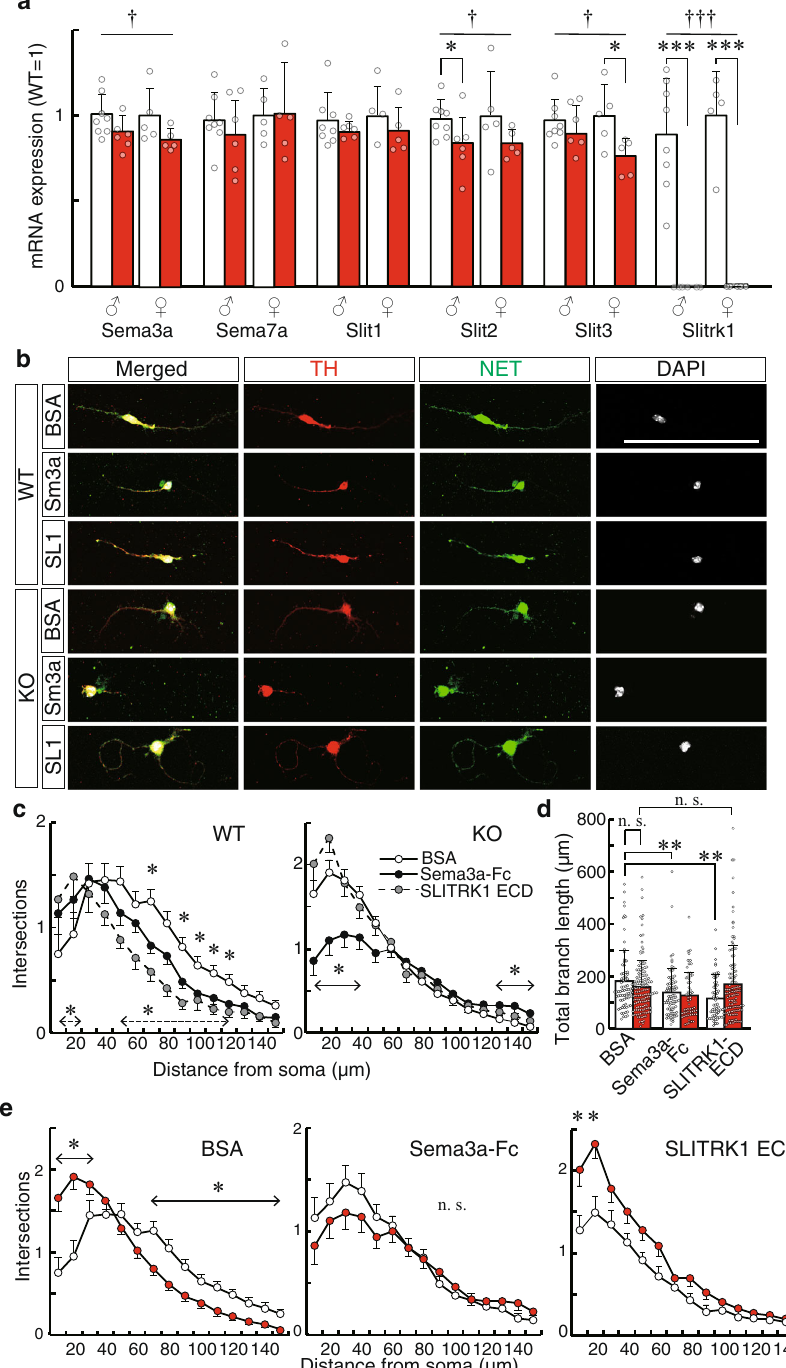
Fig. 6 Sema3a and SLITRK1 ECD suppress neurite growth of LC neurons. a Quantitative PCR of the P3 PFC. Expression levels were normalized using the WT mean values for each sex ( n = 8 mice per male group, 5 mice per female group). Data were presented as mean ± SD. The actual values and those of P7 PFC are indicated in Supplementary Table 1. b Representative images of the primary culture of LC neurons with BSA (WT, n = 74 cells; KO, n = 139 cells), Sema3a (WT, n = 77 cells; KO, n = 58 cells), or SLITRK1 ECD (WT, n = 62 cells; KO, n = 109 cells). Neurons were stained using anti-Tyrosine hydroxylase (TH, red) and NET (green). Nuclear staining was performed using DAPI (gray). Scale bar , 100 µ m. c Sholl analysis of neurites. Values are presented as mean ± SEM. Open circle , BSA treatment; fi lled circle , Sema3a treatment; gray circle , SLITRK1 ECD treatment. Statistical tests were performed in comparison to BSA at each distance ( line with double-headed arrow , Sema3a; broken line with double-headed arrow ), SLITRK1 ECD). d The total branch length. Data were presented as mean ± SD. Open bar , WT; red bar , KO. e Sholl analysis was reorganized to show the between-genotype differences. Values are presented as mean ± SEM. Open circle , WT; red circle , KO. * P < 0.05; ** P < 0.01; *** P < 0.001 in t -test ( a ), Steel ’ s test ( c ), Dunnett ’ s test ( d ), or U -test ( e ). The between- genotype differences in Sema3a, Slit2, and Slit3 in ( a ) were signi fi cant after Benjamini − Hochberg correction for multiple comparisons. To consider multiple tests in ( a ), † P < 0.05; ††† P < 0.001 (genotype) in two-way ANOVA (genotype and sex as main